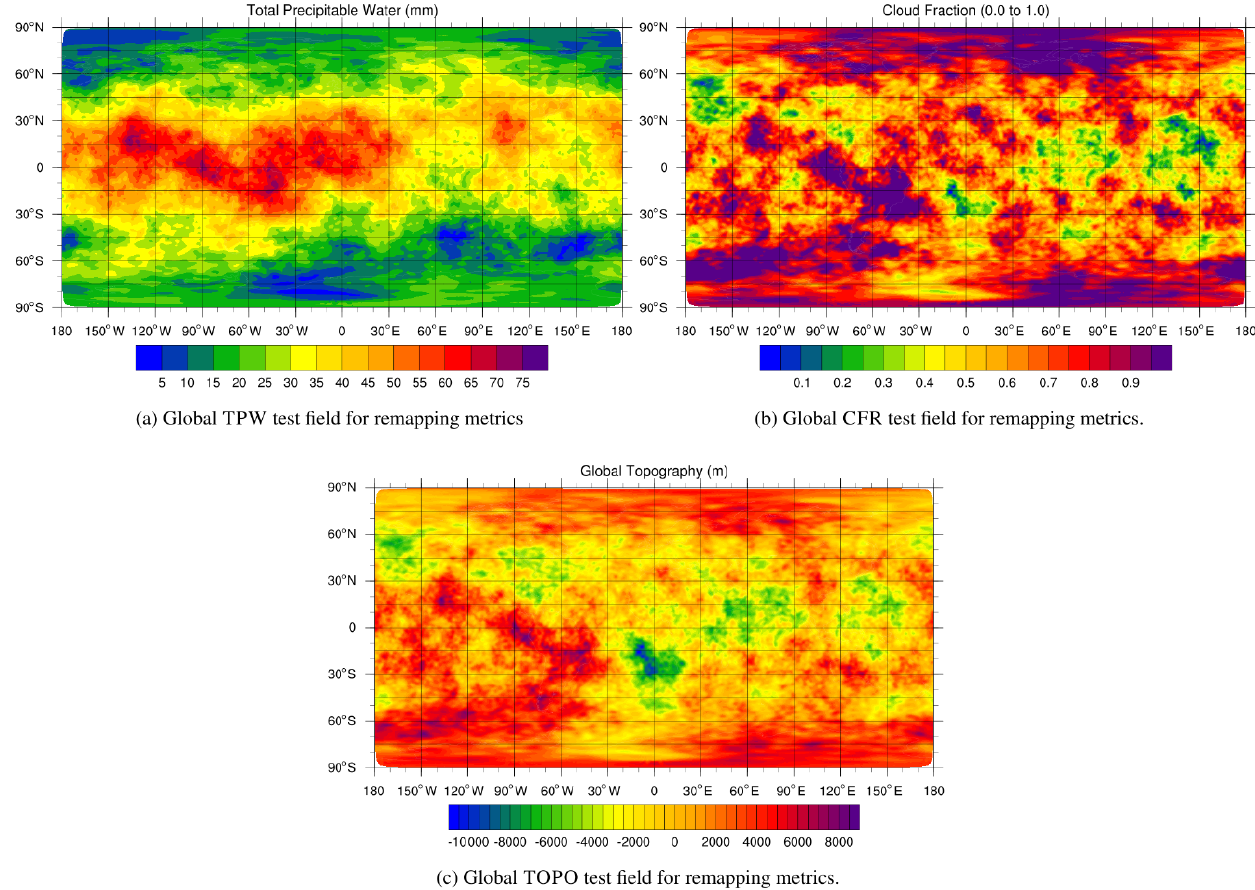
Figure 5. Randomized reconstruction of the real-world fields used in this study.